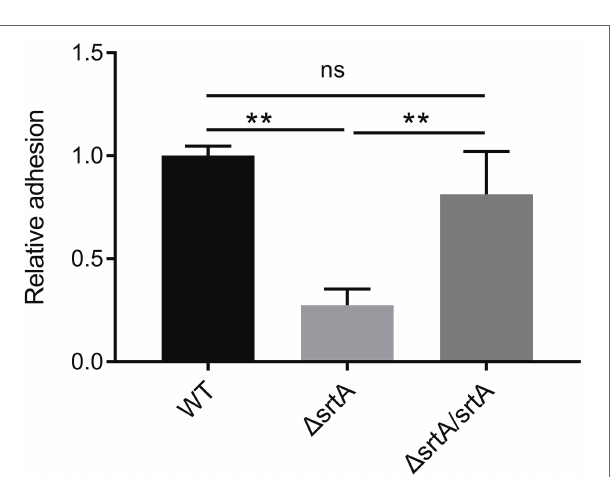
FIGURE 3 | SrtA contributes to the adhesion of L. gasseri Kx110A1 to human gastric epithelial AGS cells. Adherence of L. gasseri Kx110A1 and its derivatives to AGS cells. Data represent the means ± SD of three independent experiments, ** p < 0.01, ns, no significance.